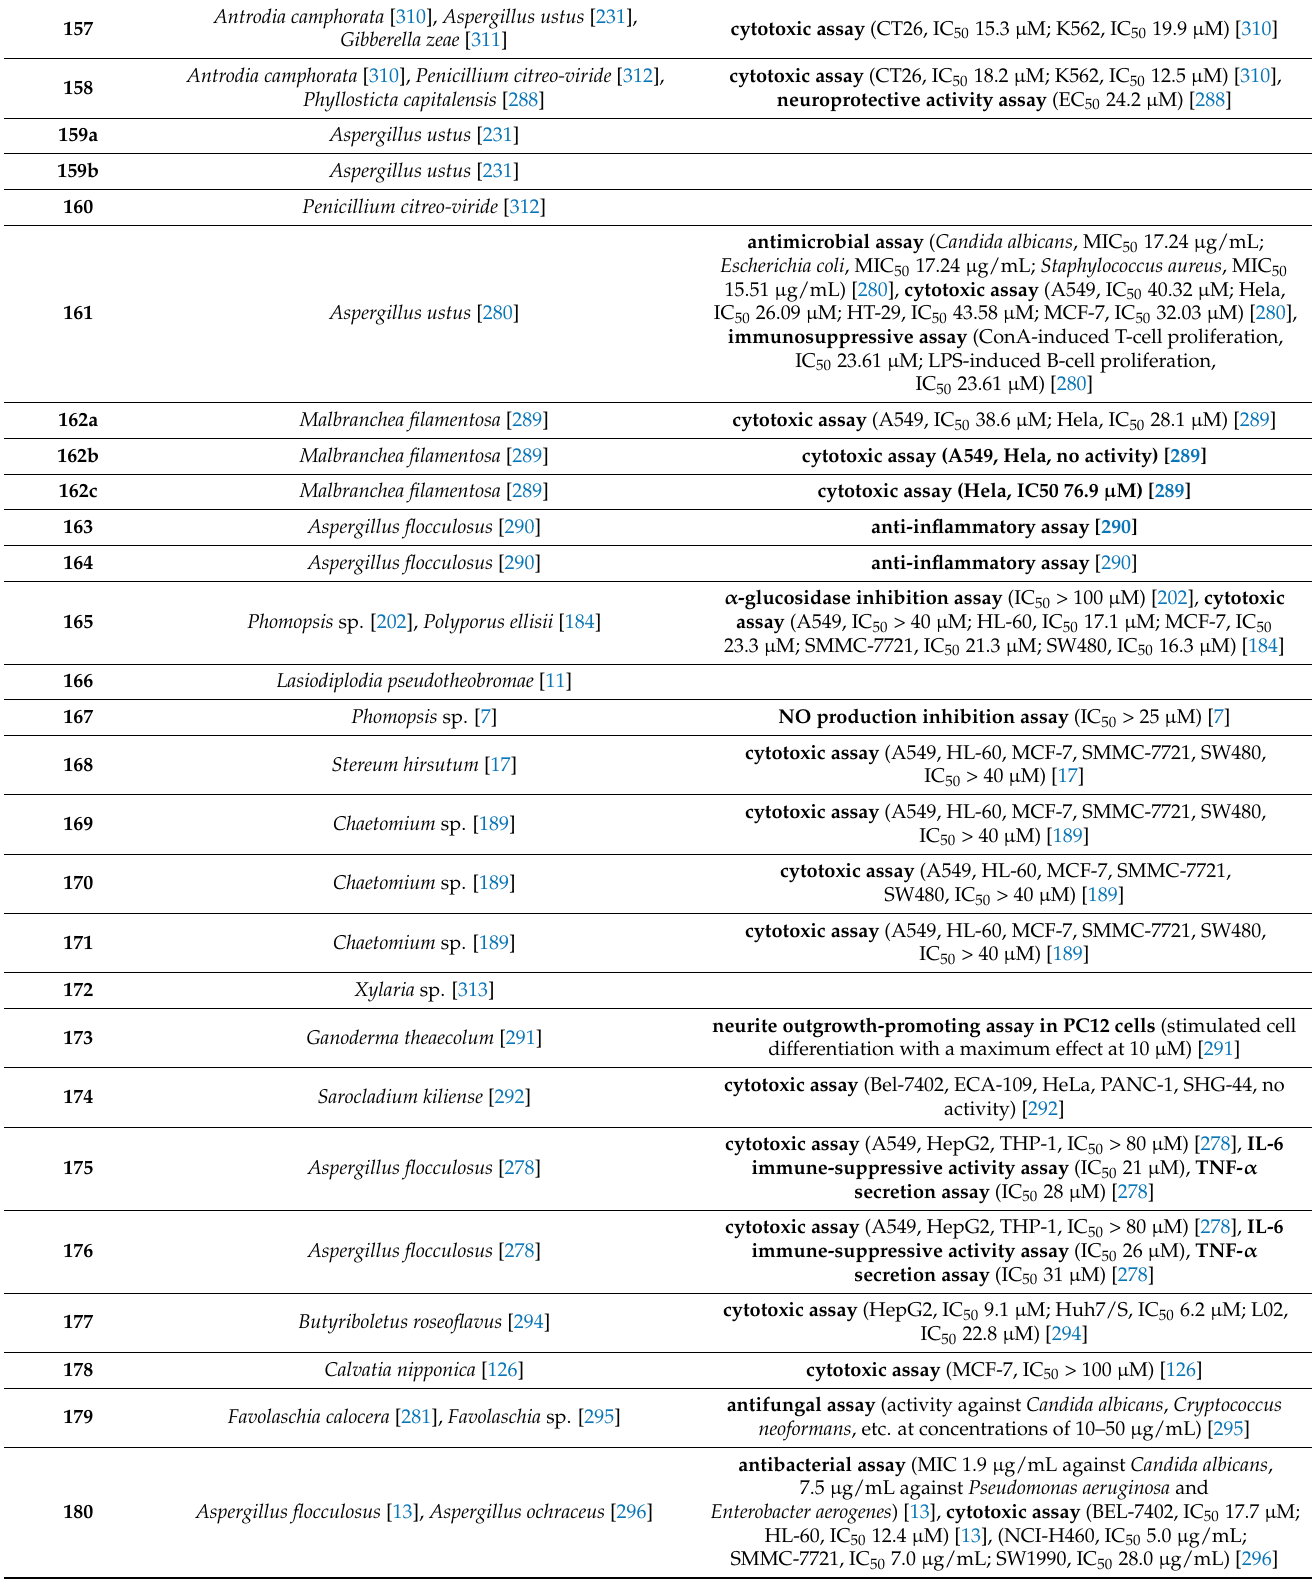
Table 7. Sources and biological activity of fungal steroids with a rearranged tetracyclic carbon skeleton. Compound Fungal Source